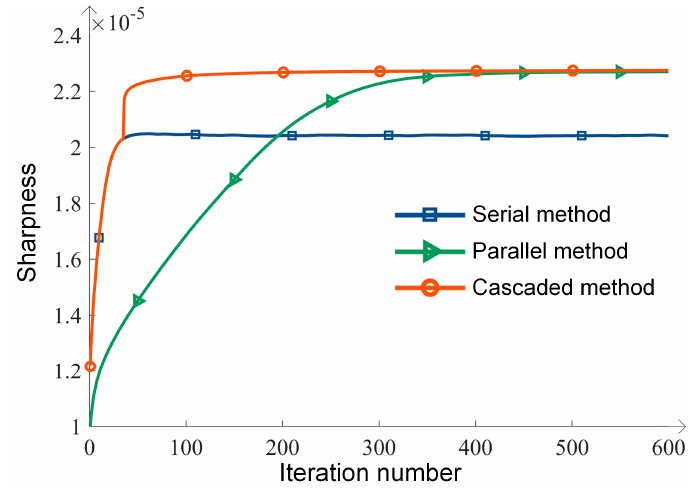
Table 1. Reconstructed performance comparison of the three methods.